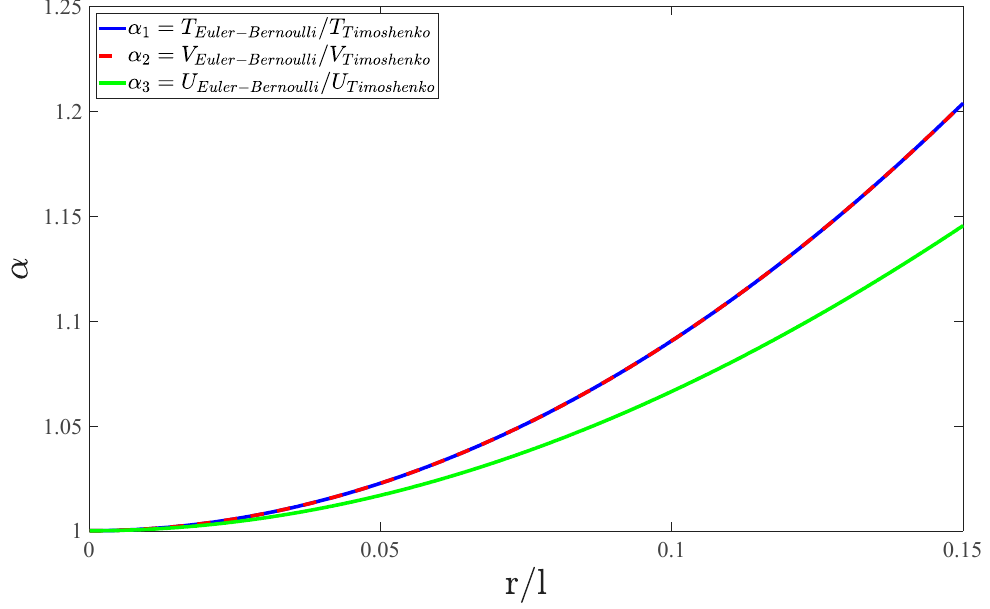
Figure A6 . The variation of ratios α (cid:2869) , α (cid:2870) and α (cid:2871) versus the parameter r/l Figure A6. The variation of ratios α 1 , α 2 and α 3 versus the parameter r / l